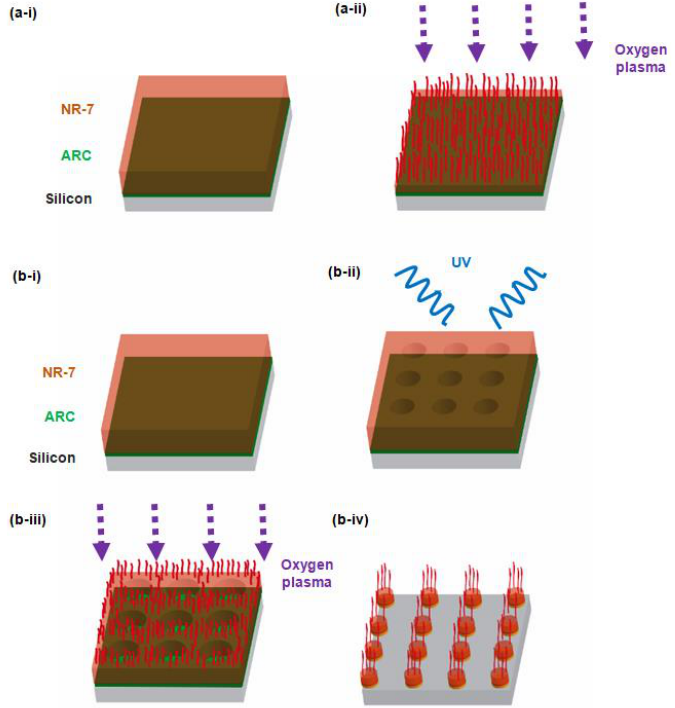
Figure 1. ( a ) Schematic of the fabrication of monotonous polymer nanostructures on a planar surface: ( a - i ) Spin-coating of anti-reflective coating (ARC) and NR-7 polymer on a polished silicon substrate; ( a - ii ) Patterning of polymer nanostructures via maskless oxygen plasma etching. ( b ) Schematic of